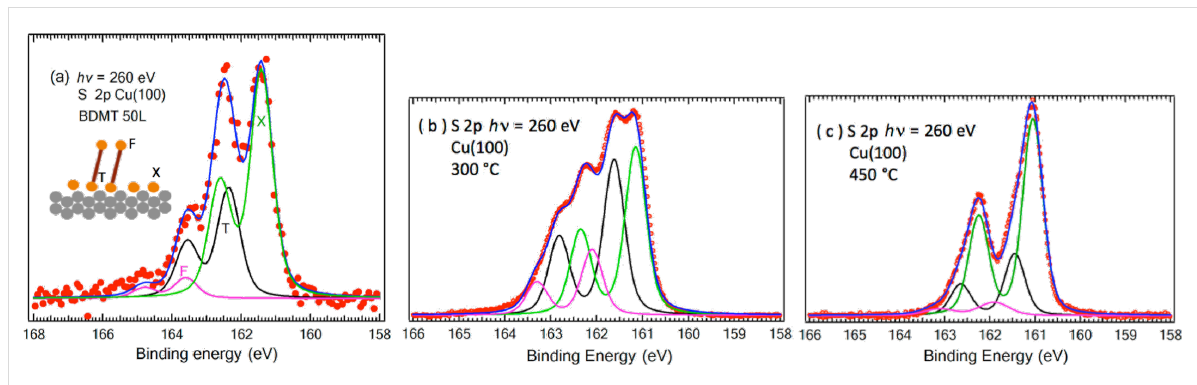
Figure 2: (a) S 2p XPS spectra for a small dose of BDMT evaporated [26] onto Cu(100). (b,c) S 2p spectra for S adsorption onto Cu(100) [82] from Na 2 S. The solid lines are fits using Voigt contours and the appropriate spin–orbit splitting of the S 2p 3/2 and S 2p 1/2 components. Figure adapted with permission from [82], copyright 2014 American Chemical Society.